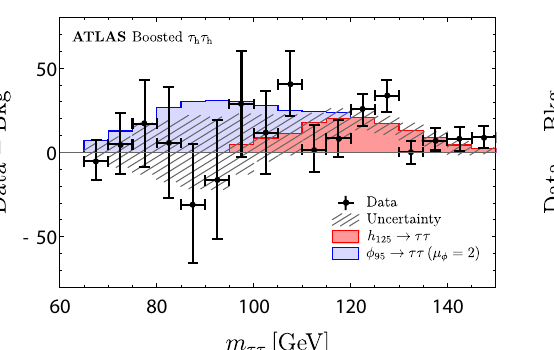
Fig. 2 The histograms of the additional resonance φ (blue) and SM Higgs (red) event shapes are shown with the experimental data (cross) and their uncertainties (dashed band). The left panel is for the boosted